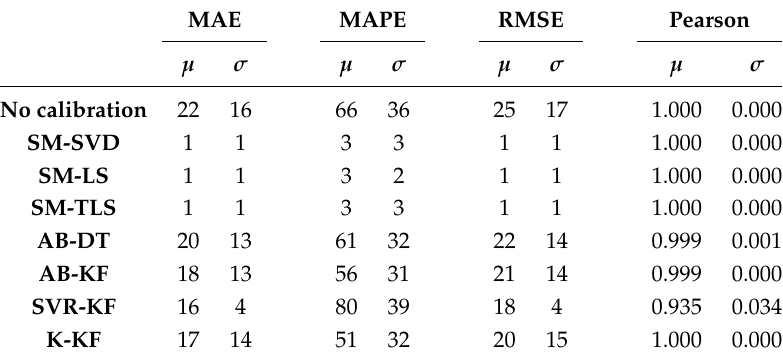
Figure 7. Evolution of the MAE computed for each week of the drift period between the drifted values and the true values, and between the corrected values for each strategy and the true values for a particular sensor, after the start of drift. MAE for SVR-KF is nearly always worse than those for AB-DT, AB-KF and K-KF until week 24 but are better afterwards. The performances of SVR-KF could be explained by the presence of a bias, at least according to this metrics, as its evolution is quite flat. Table 3. Mean and standard deviation of the weekly mean of each metric for s 1 during the drift period. From the standard deviations of MAE, MAPE and RMSE, the observations made based on Table 1 could be locally false, for example, a strategy is better than others considering a computation of the metrics over the 12 weeks of drift but not always considering a computation of the metrics over each week. MAE MAPE RMSE